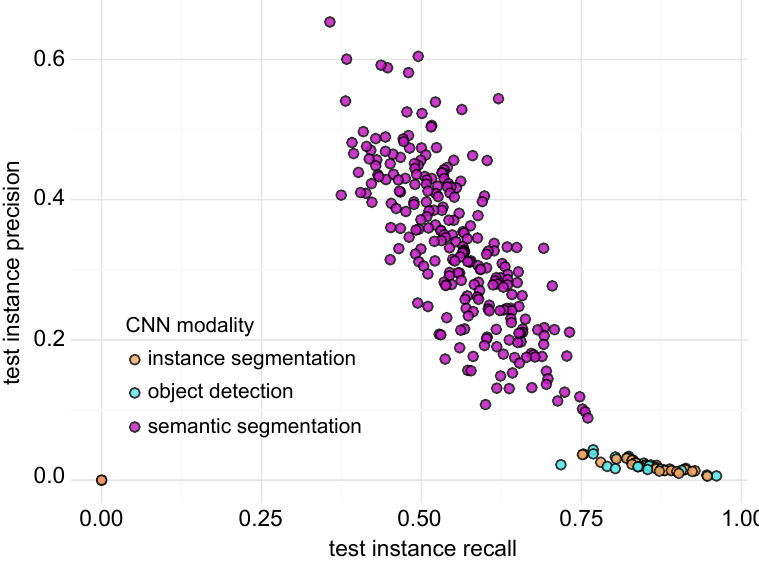
Figure 3. Expert-selected test set f1-score for hyperparameter search experiments from different computer vision domains. To ensure a fair comparison of models from different domains, semantic segmentation output masks are passed through a sigmoid transform and thresholded to extract mask centroids. Similarly, instance segmentation and object detection output bounding boxes are converted to centroids to evaluate matches with ‘truth’ centroids. To avoid unnecessary expenditure of GPU credits, experiments that did not perform well on the validation set (validation f1-score > 0.7 for semantic segmentation models and >0.5 for instance segmentation and object detection models) were not carried into